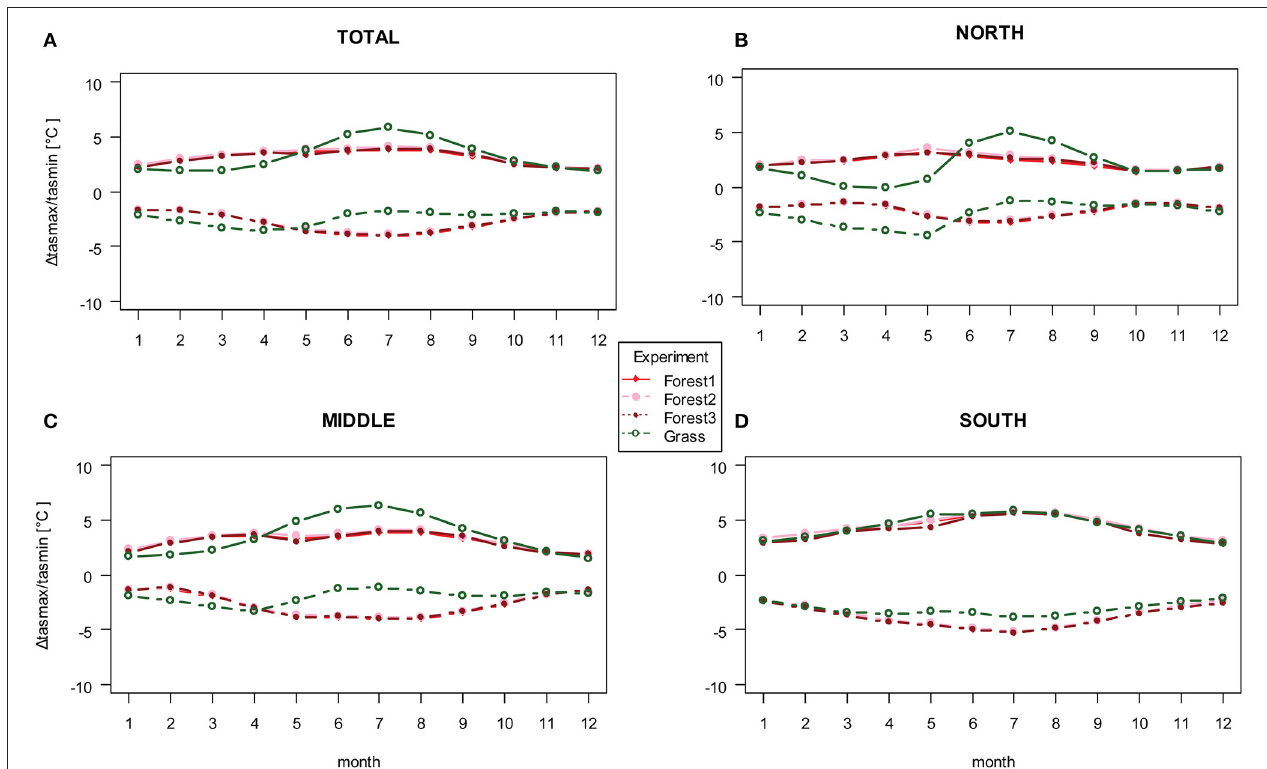
FIGURE 5 | Domain averaged long-term mean seasonal cycle difference of maximum and minimum near-surface temperature of FOREST1 (red), FOREST2 (rose), FOREST3 (dark red), GRASS (dark green) relative to EVALUATION over all land points only for 1986–2015. Values are displayed for the whole of the domain TOTAL (A) , and with latitudinal separation in NORTH (B) for high-latitudes, MIDDLE (C) for mid-latitudes, SOUTH (D) for the Mediterranean.